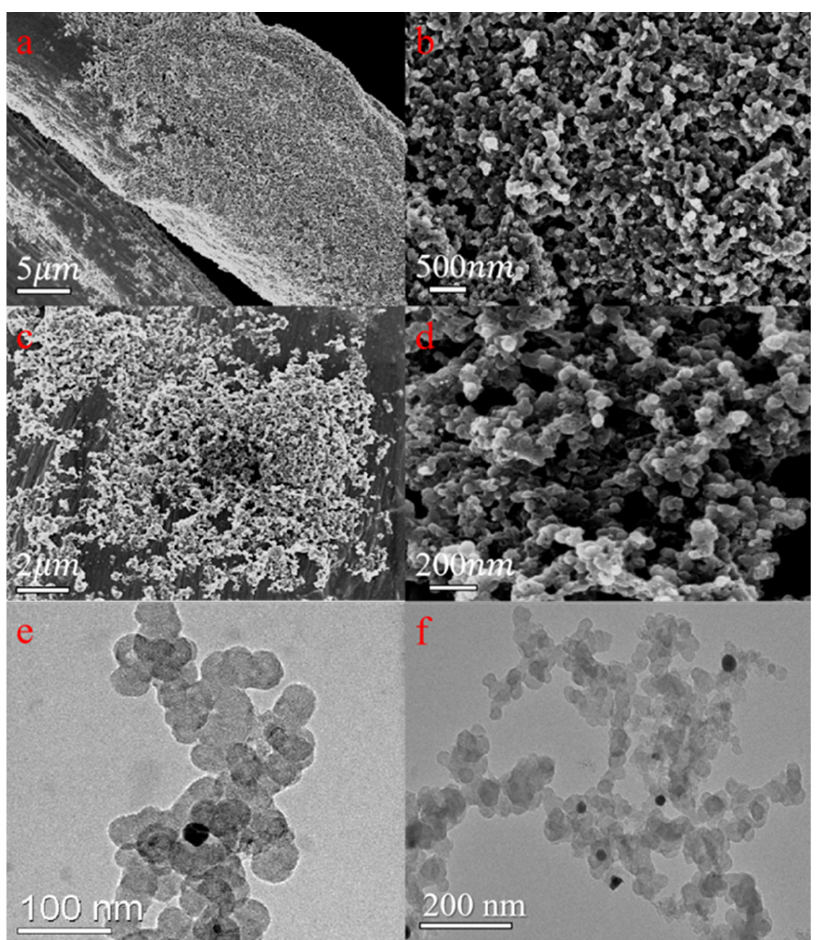
Figure 2. SEM cross-section images ( a , b ) of Pd/C@CF, SEM surface images ( c , d ) of Pd/C@CF and HRTEM image ( e , f ) of Pd/C catalyst.